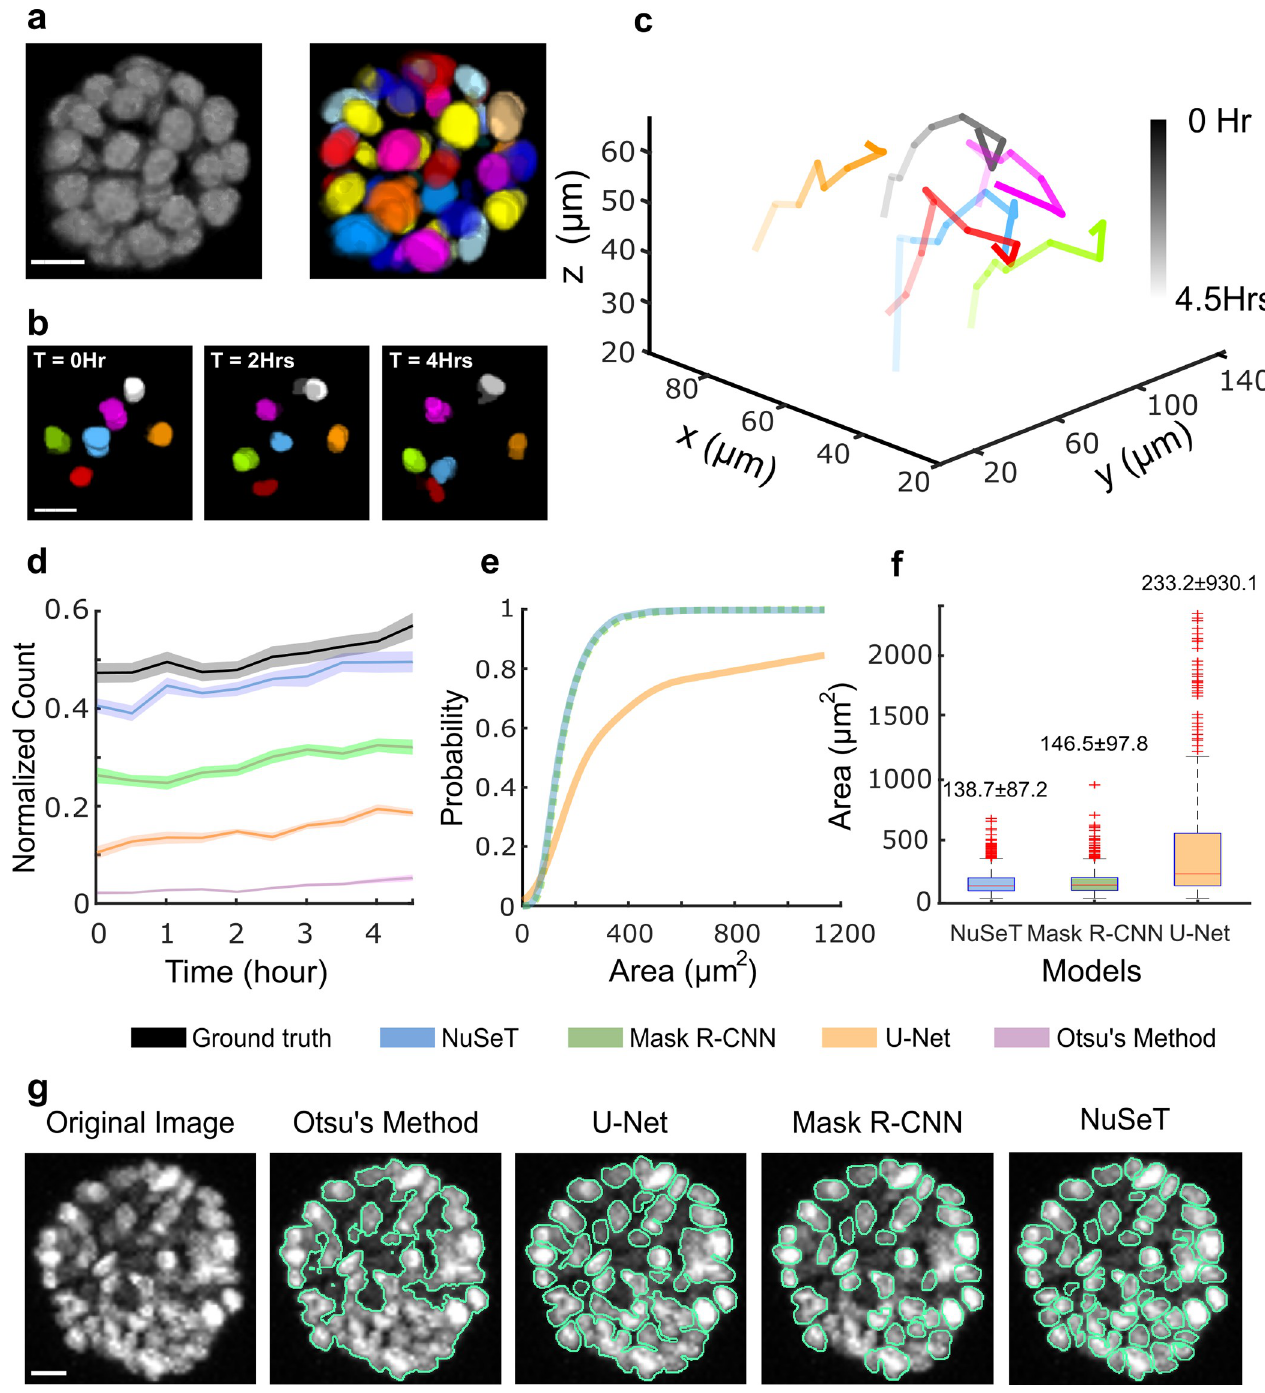
Fig 4. NuSeT effectively segments single nuclei in disorganizing dense mammary acini. ( A) Representative 3D MCF10AT acinus segmentation using NuSeT. (B) Nuclei tracking. For ease of visualization, only a few of the segmented nuclei are shown at different time points. (C) 3D tracks of the nuclei shown in ( B ) over time, from 0 h (dark) to 4.5 h (light). (D) Number of nuclei detected in disorganizing acini at different time points using different segmentation methods. Data were collected from 8 representative acini and were normalized by the total number of nuclei at the last time point. Data from the first 5 hours are shown. (E) Cumulative distribution function plots of area of nuclei segmented using different methods. (F) Box plots of nuclear area distribution. The median area for each method is indicated on the top. The area box plot for Otsu’s method (median area: 2816.6 ± 2845 μ m 2 ) is shown in S6 Fig. (G) Representative examples comparing nuclei segmentation in dense mammary acini using different methods. Scale bars are 20 μ